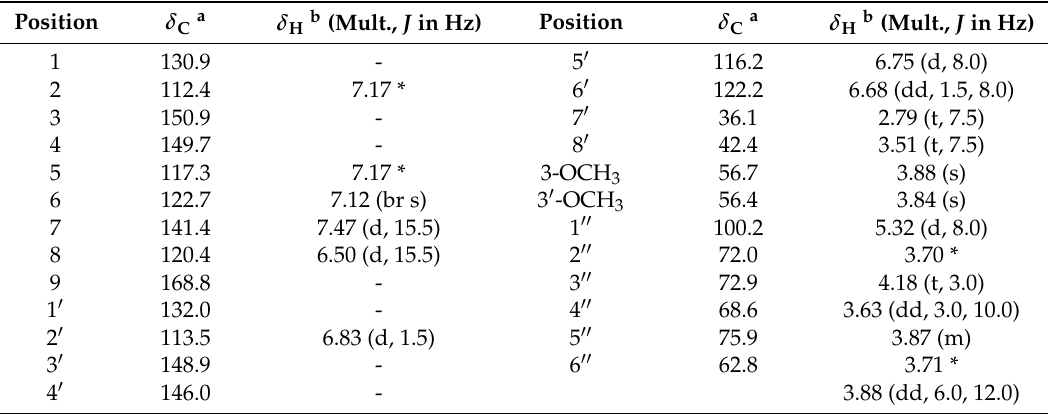
Table 1. 1 H- and 13 C-NMR data of 3 in CD 3